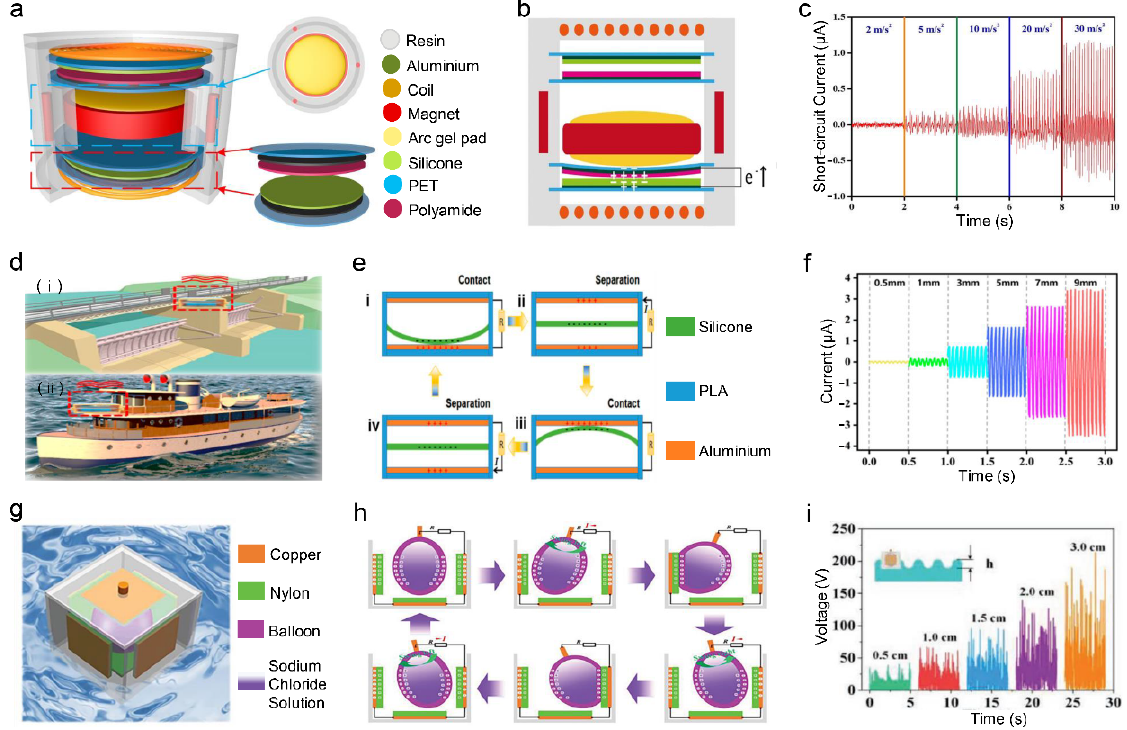
Figure 7. A planar contact vibration sensor. ( a ) Structural diagram of hybrid generator. ( b )